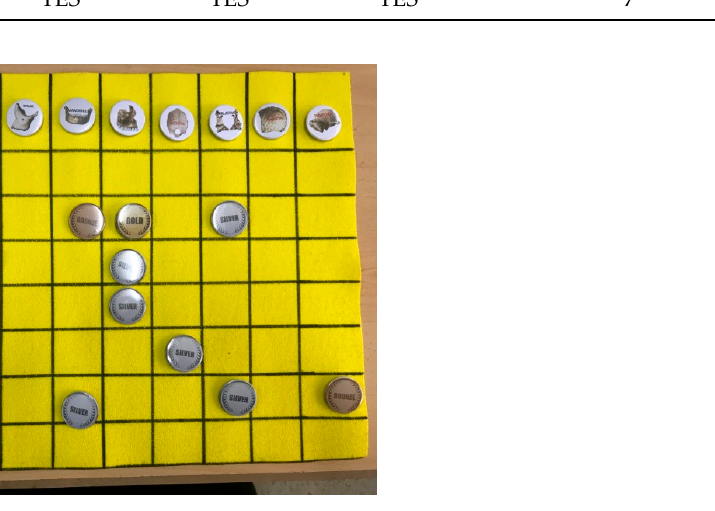
Figure 1. Badges and Team Ranking of RB-G-SIDRA (gamified SIDRA with ranking and badges).